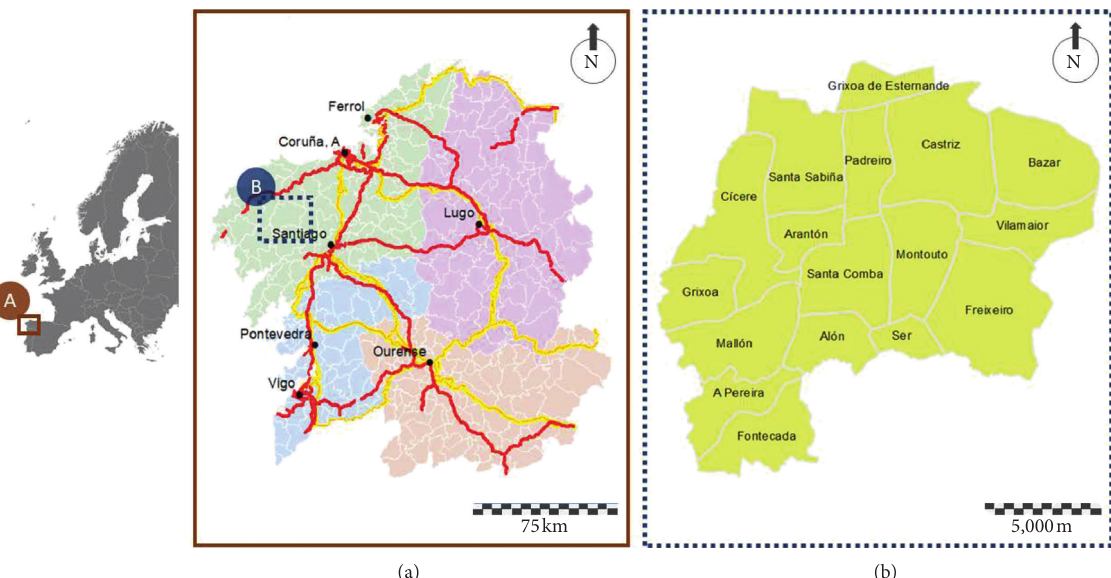
Figure 1: Location of the study area. The municipality of Santa Comba is located in the northwestern sector of the region of Galicia, Spain. In the box ( A ), the black-labeled nodes correspond to the most populated cities, whereas the indicated lines show the most important road infrastructures. High-capacity roads are displayed in red color and railways in yellow. In box ( B ), the distribution in parishes within the study area is shown. (a) Zoom A . (b) Zoom B